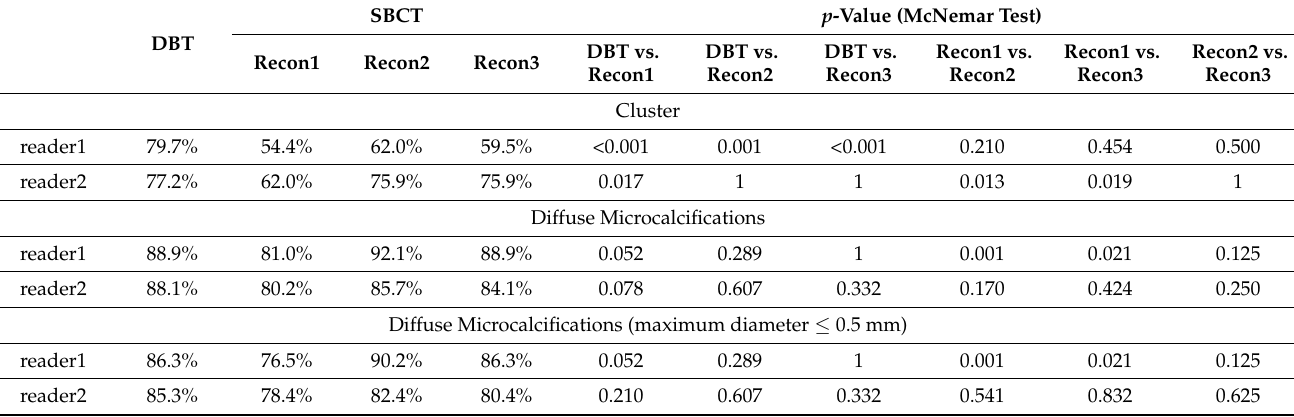
Table 2. Correct classification of cluster, diffuse microcalcification, and diffuse microcalcifications with a maximum diameter ≤ 0.5